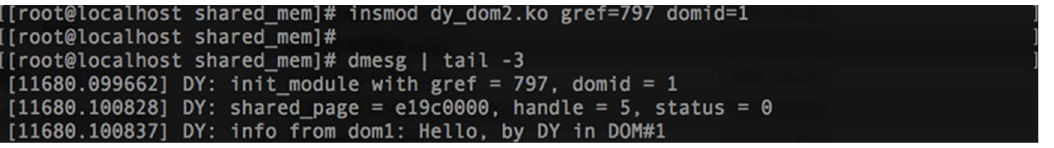
Figure 6. Refer shared memory in VM2, without PVMH module.